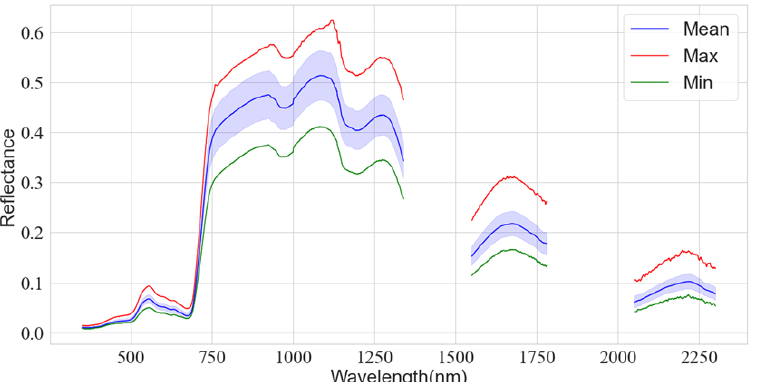
Figure 8. Field measured spectral curves. The Max line is the highest reflectivity hyperspectral. The Min line is the lowest reflectivity hyperspectral curve. The Mean line shows the mean and variance of the spectrum.